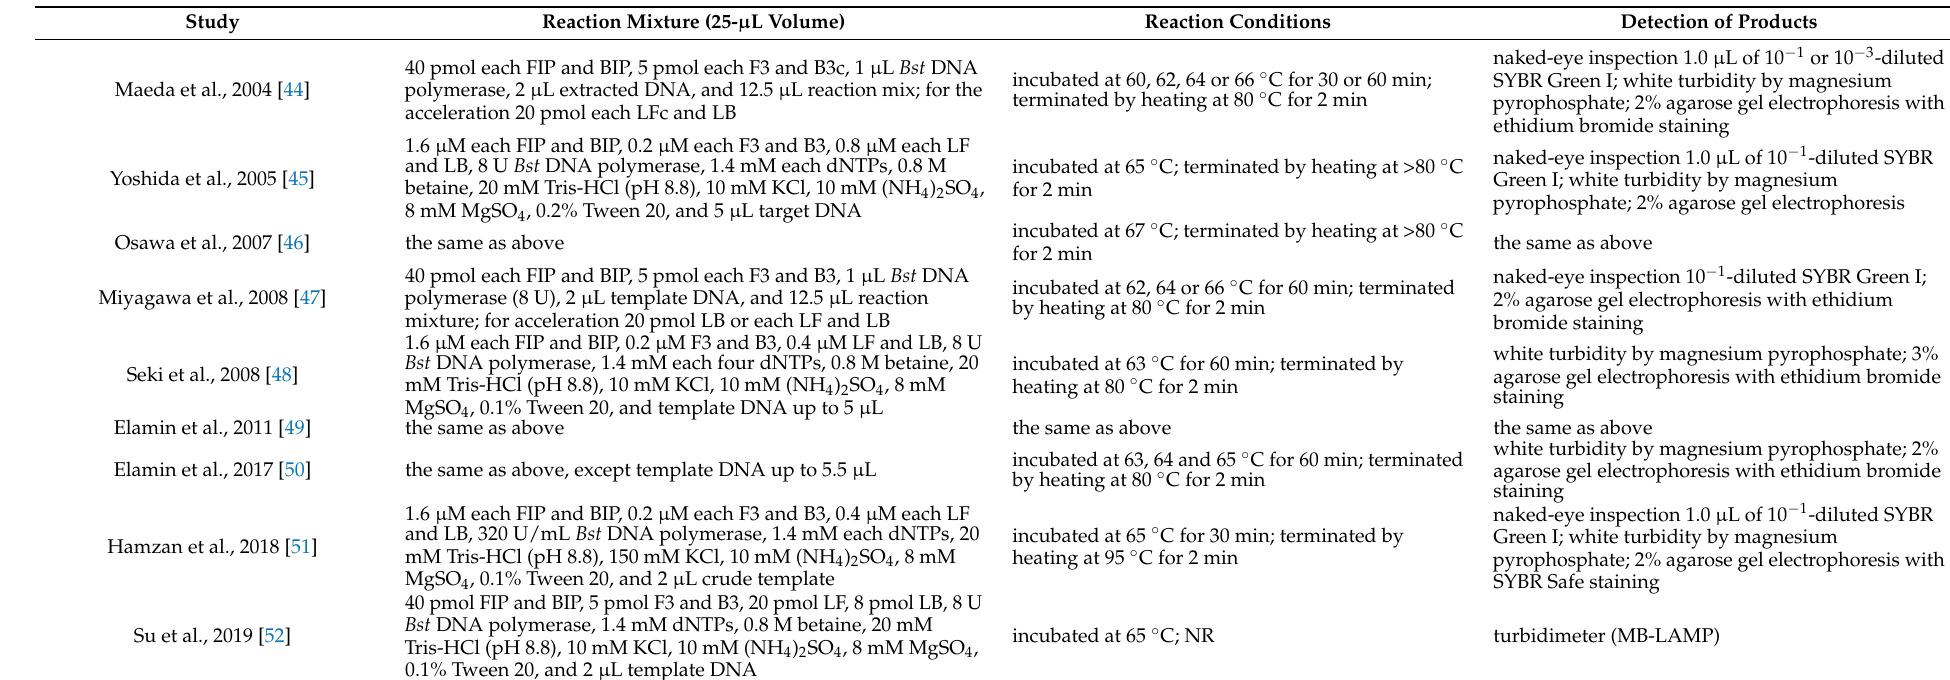
Table 2. The parameters of the conducted loop-mediated isothermal amplification (LAMP)